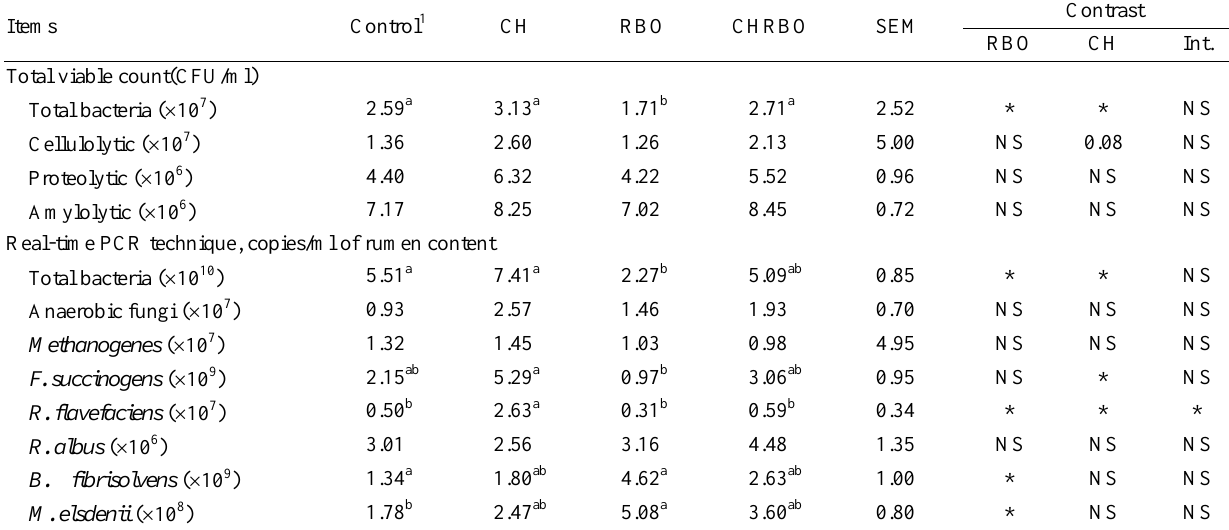
Table 5. Effect of cassava hay and rice bran oil on rumen microorganism population in lactating dairy cows